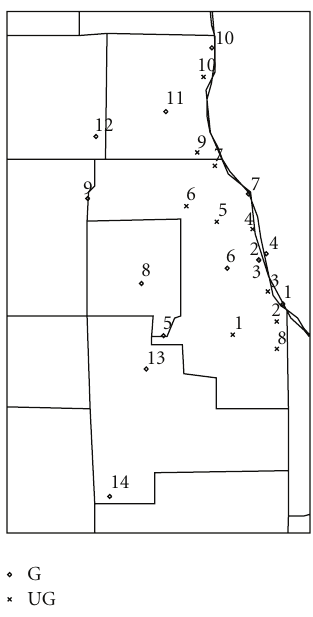
Figure 1: Geographical locations for the Chicago AQS database (2000), where the latitude and longitude are measured in degrees. (G: gauged sites; UG: ungauged sites).